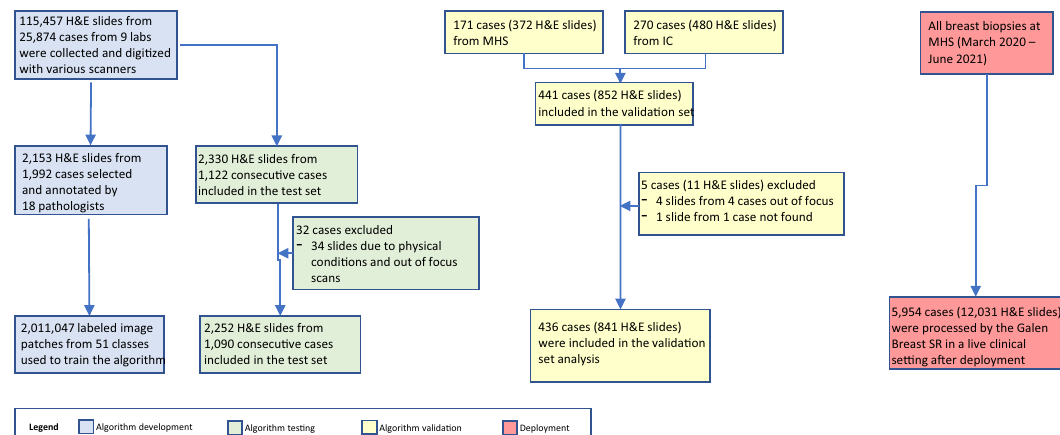
Fig. 1 Study fl ow chart detailing the cases analyzed and the different study phases.